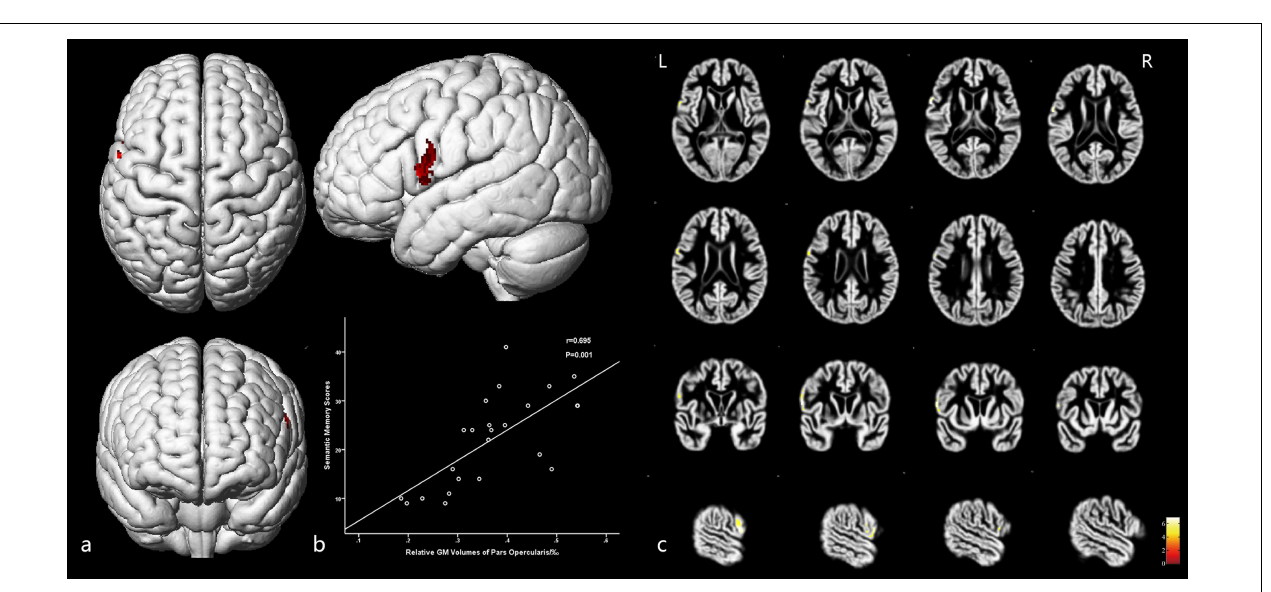
FIGURE 6 | The cortex related to semantic memory and their Pearson correlation coefficients. (a) Three-dimensional image. (b) Correlation between semantic memory scores and regional relative GM volumes. (c) Slice view. GM volumes of the posterior inferior frontal gyrus were positively related with the semantic memory scores. L: left, R: